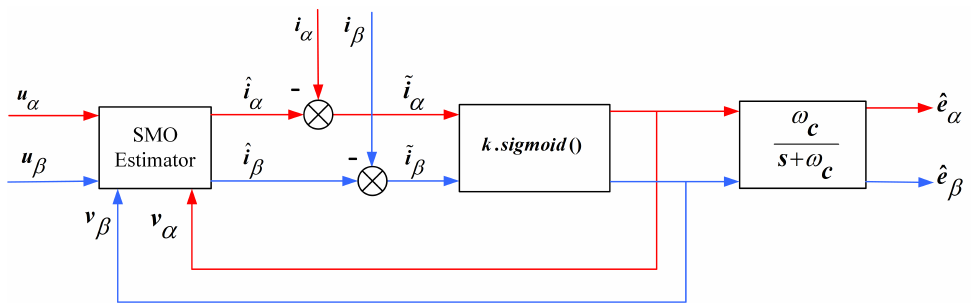
Figure 7. Block diagram of conventional SMO method